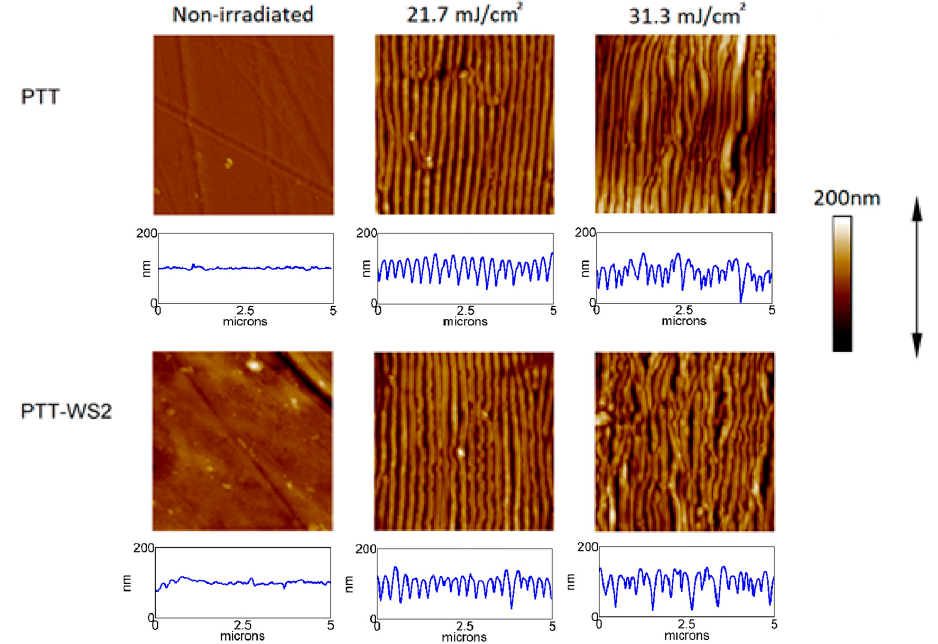
Figure 1. AFM images (5 × 5 μ m 2 ) and height profile over a five-micron horizontal line of PTT and PTT-WS 2 samples after irradiation with 10,000 pulses with increasing fluences. The laser polarization follows the direction of the arrow.